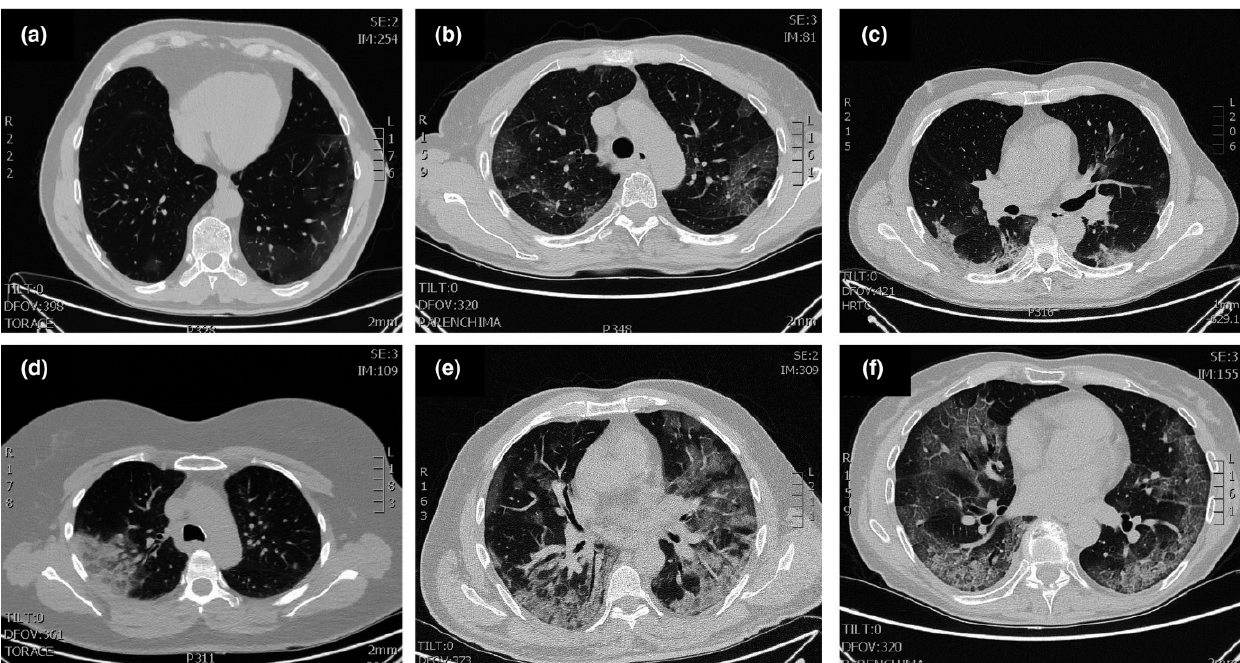
Figure 3. Typical patterns of COVID-19 at CT imaging. ( a ) Ground glass shadows (early stage), ( b ) Ground glass opacities, ( c ) Ground glass nodules and subpleural consolidation, ( d ) Focal consoli- dation, ( e ) Multifocal consolidation, ( f ) Multifocal consolidation with honeycomb (end stage). Reproduced with permission. Ref. [1] Journal of Internal Medicine © 2022 John Wiley and Sons, Inc.